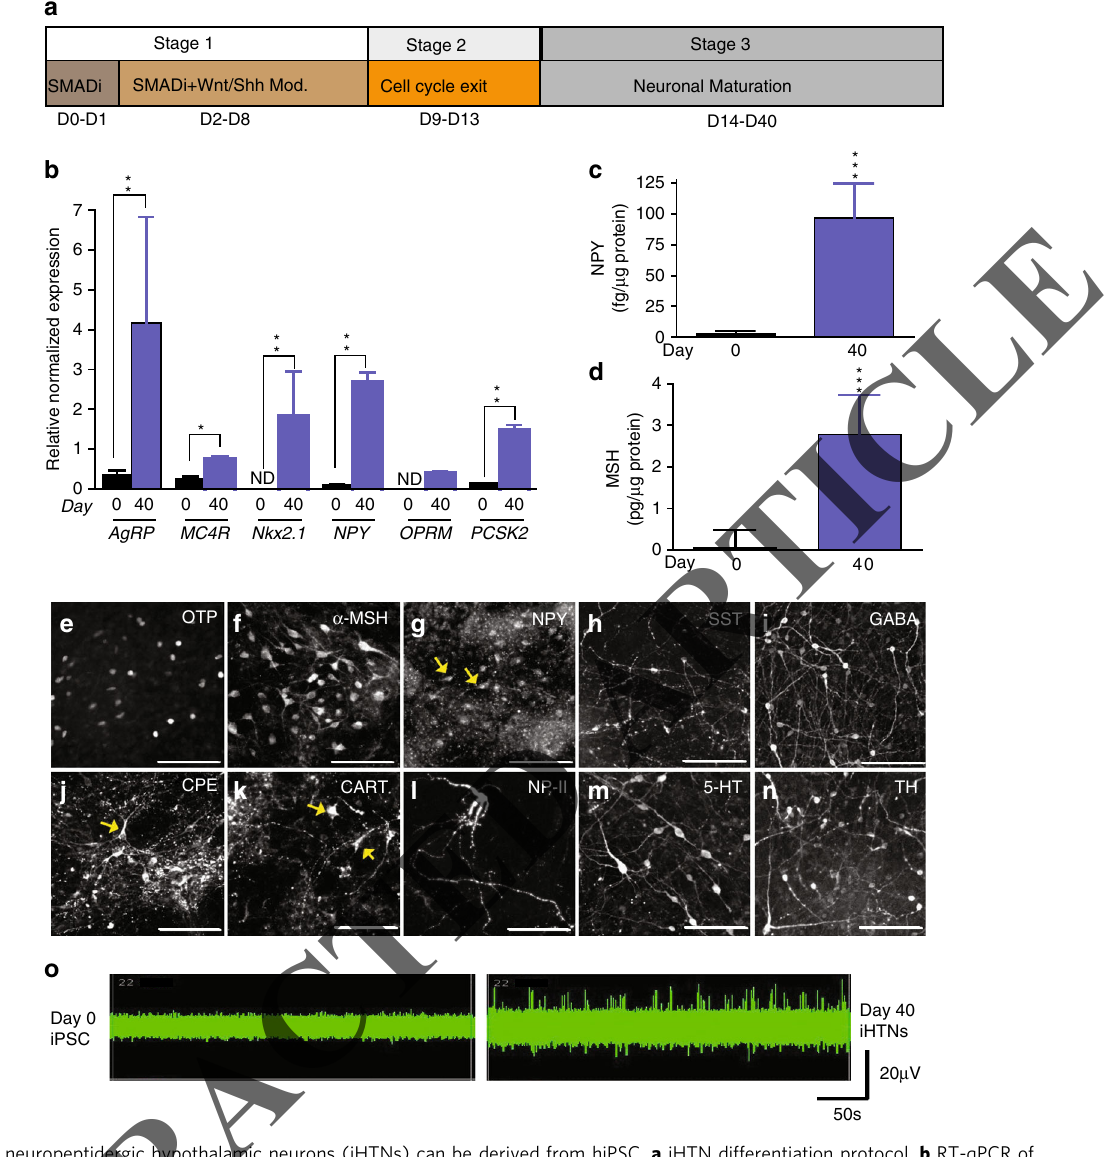
Fig. 2 Functional neuropeptidergic hypothalamic neurons (iHTNs) can be derived from hiPSC. a iHTN differentiation protocol. b RT-qPCR of hypothalamic and arcuate nucleus-speci fi c genes showing signi fi cantly increased expression of the genes at day 40 of differentiation compared with day 0 (* p < 0.05, ** p < 0.01). ND not detectable; two-way ANOVA was employed to determine differences within day 0 and day 40 iHTNs. c Measurement of